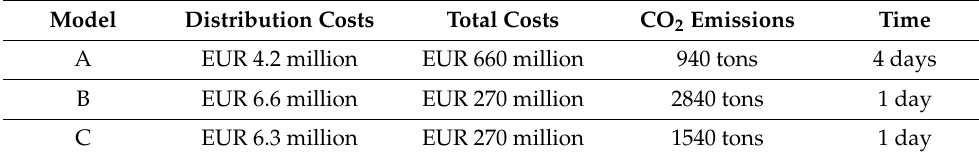
Table 9. Final assessment of the three LNG distribution